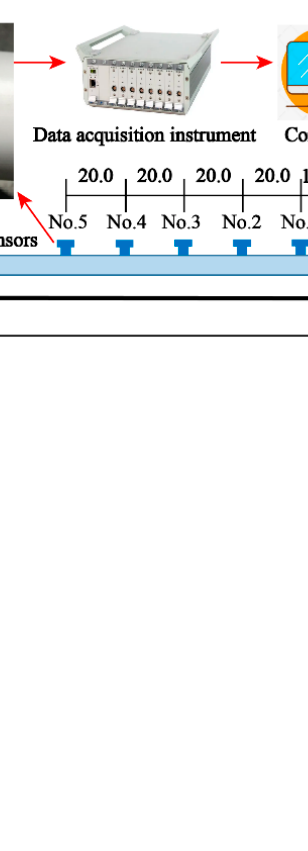
Figure 3. Cross-section details of experimental cable. Table 1. Parameters of the experimental cable.